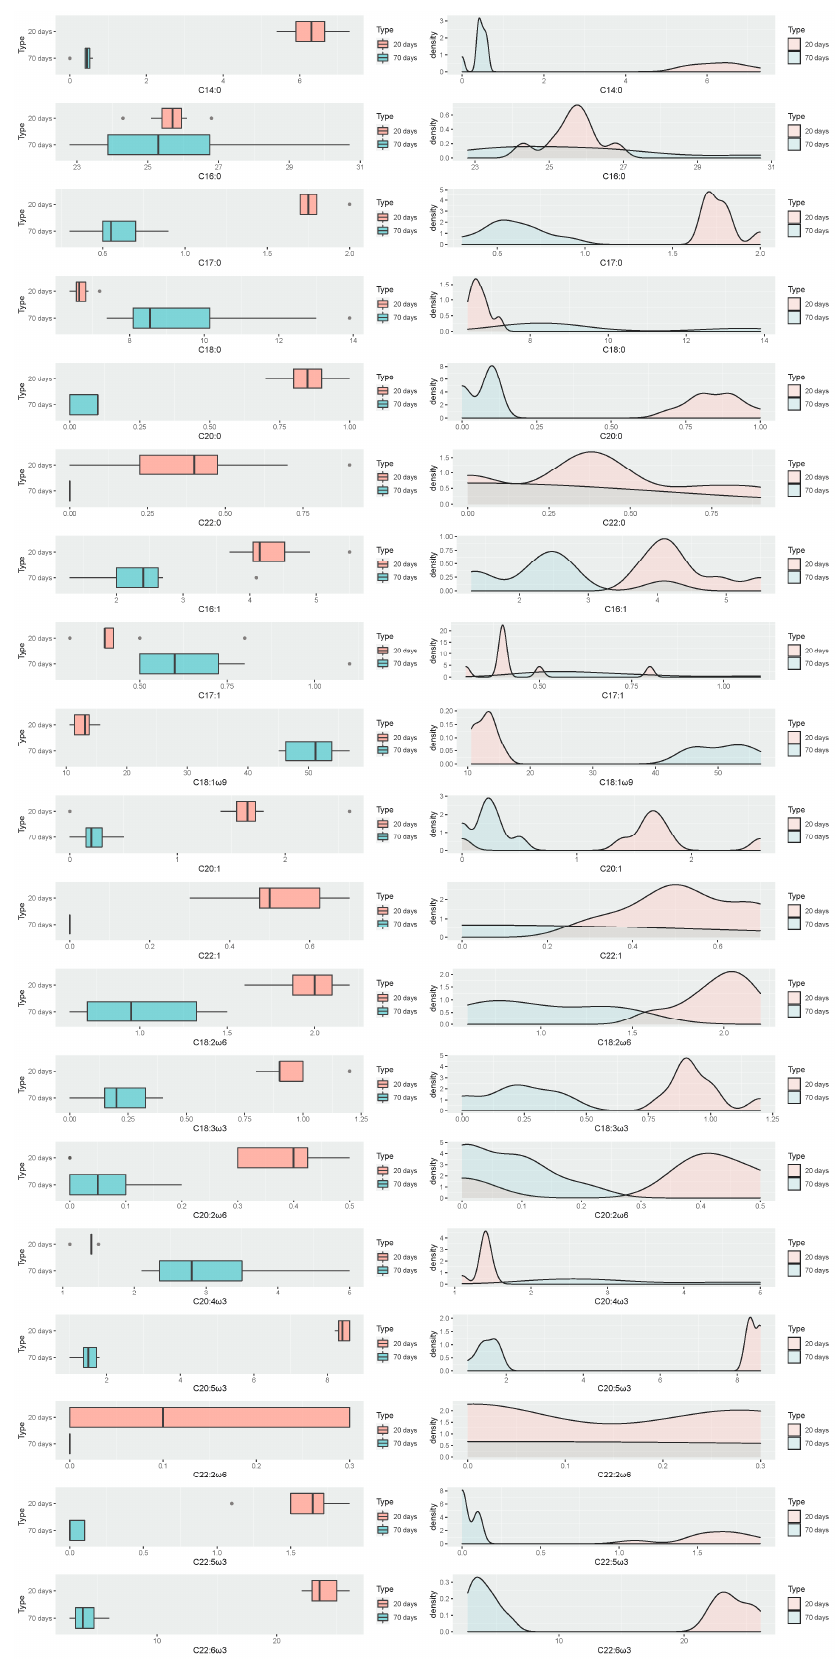
Figure 4. Boxplot and distribution plots of FAs according to the sampling period (day 20 vs. day